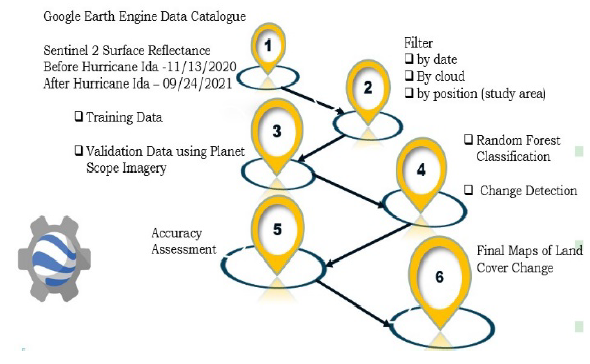
Figure 2. Research